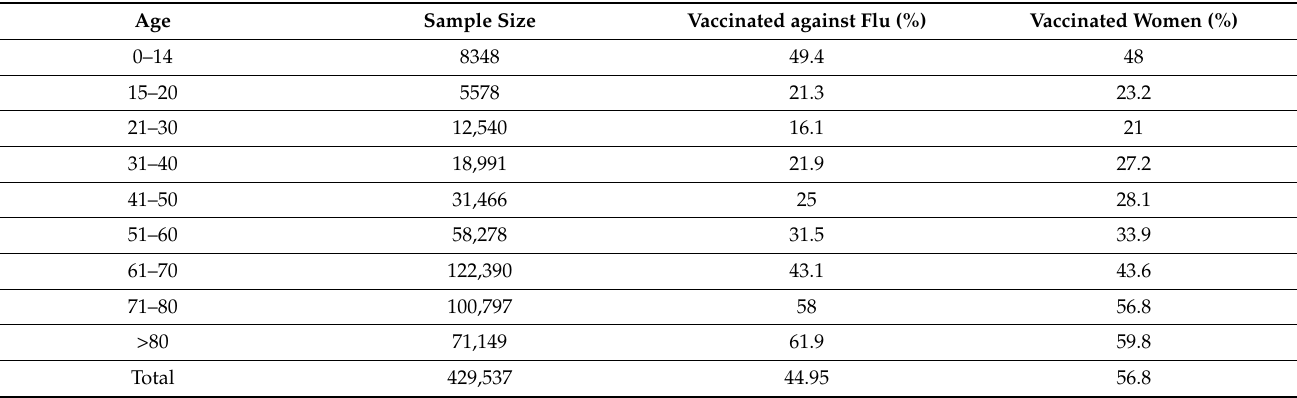
Table 1. Percentage of people contracting COVID –19 who were vaccinated against flu, according to age and sex.